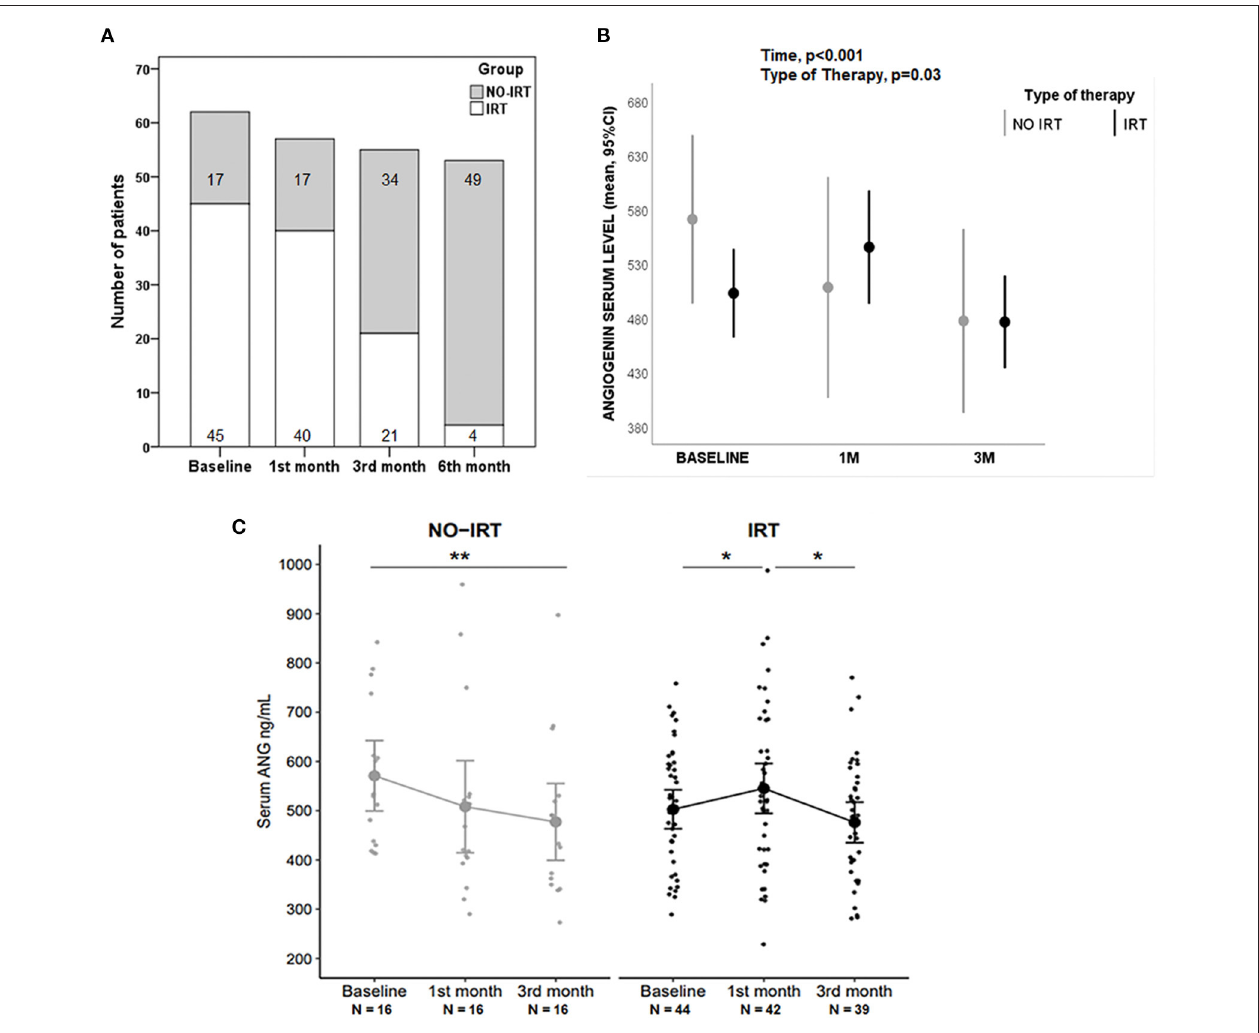
FIGURE 3 | Angiogenin (ANG) blood levels during rehabilitation. (A) Bar graph showing the number of patients under IRT and NO-IRT over time, changing according to early improvements in the IRT group. (B) Graph comparing how time and type of therapy influenced the serum levels of ANG, assessed with ANOVA for repeated measures. (C) Jitter plots showing the temporal profile of ANG levels in NO-IRT and IRT groups; Differences were assessed with Wilcoxon tests, * p < 0.05, ** p < 0.01. Mean with 95% CI are represented in